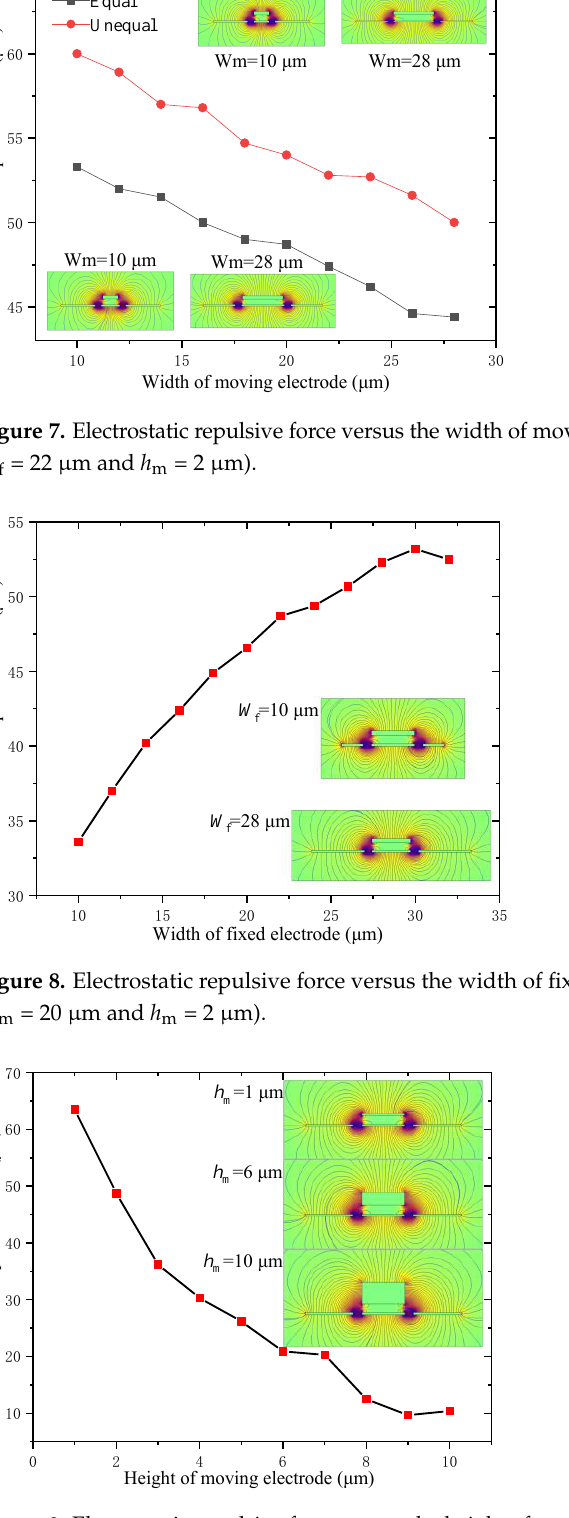
Figure 9. Electrostatic repulsive force versus the height of moving electrode ( V = 500 V, d 1 = d 2 = 4 μm, W m = 20 μm and W f = 22 μm) .